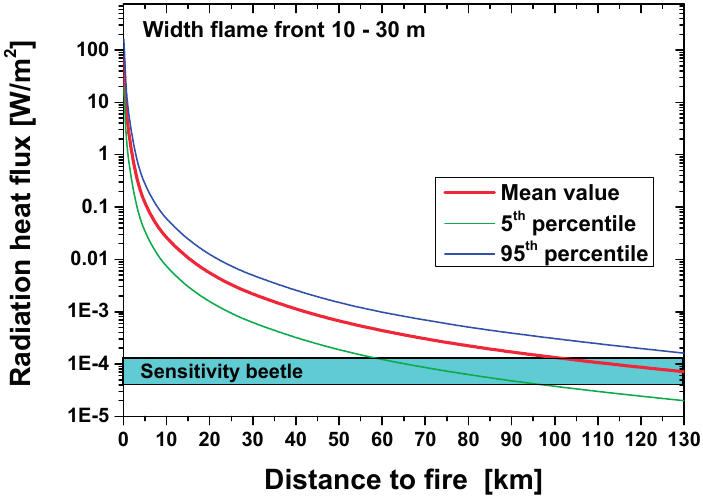
Figure 5. Radiation heat flux (flame front 10–30 m) as function of the fire